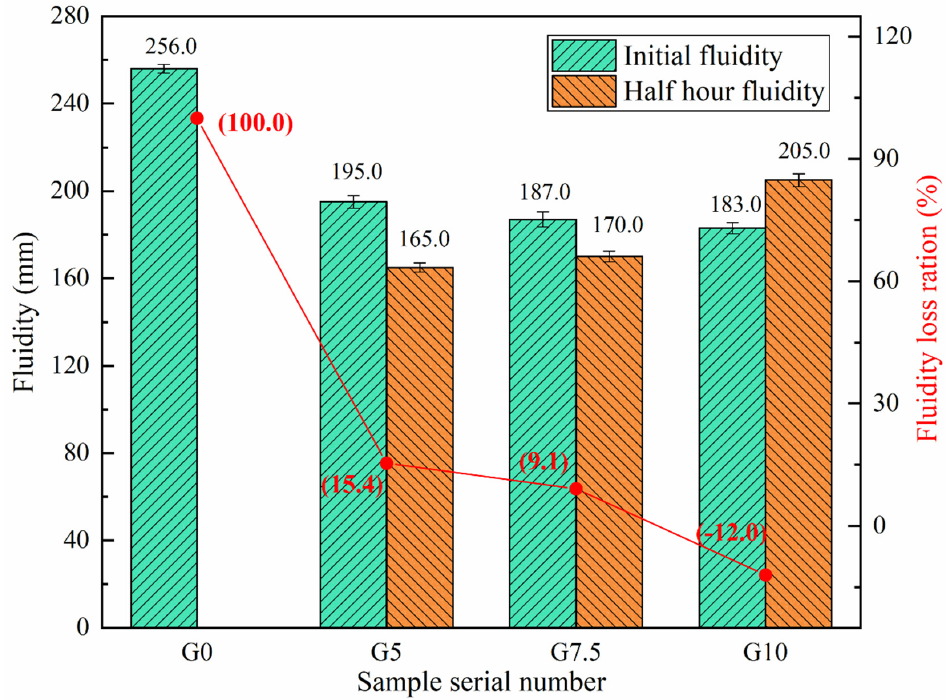
Figure 5. Effect of different water glass contents on the fluidity of MPC at − 5 °C.